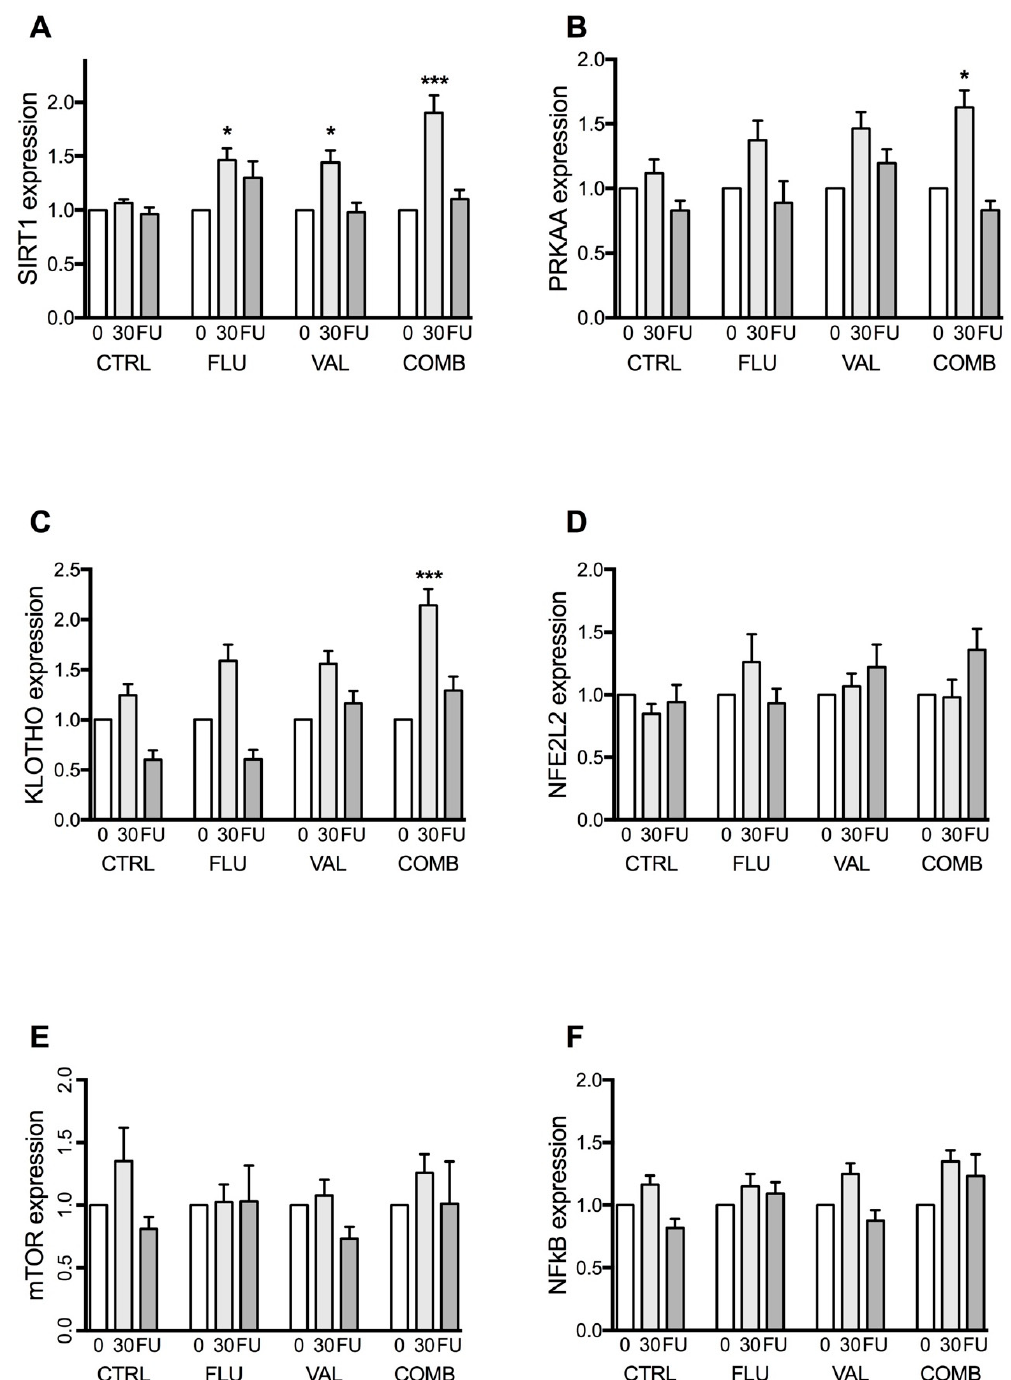
Figure 1. The expression of longevity genes: ( A ) SIRT1 , ( B ) PRKAA , ( C ) KLOTHO , ( D ) NFE2L2 , ( E ) mTOR , and ( F ) NF- κ B in placebo (CTRL), low-dose fluvastatin (FLU), low-dose valsartan (VAL), or low-dose fluvastatin and valsartan combination (COMB). “0” represents the time before treatment, “30” represents the end of treatment, i.e., after 30 days (30) and “FU” represents five months after treatment discontinuation. Values are presented as means ± SEM. Presented p values are after Benjamini-Hochberg false discovery rate (FDR) correction, significance threshold set at p < 0.05. * signifies p < 0.05 and *** p < 0.001, vs. control group. SIRT1 —sirtuin 1 gene; PRKAA —5 (cid:48) -AMP-activated protein kinase catalytic subunit α -2 gene; NFE2L2 —nuclear factor (erythroid-derived 2)-like 2 gene; mTOR —mechanistic target of rapamycin (mTOR) gene; NF- κ B1 —nuclear factor κ B